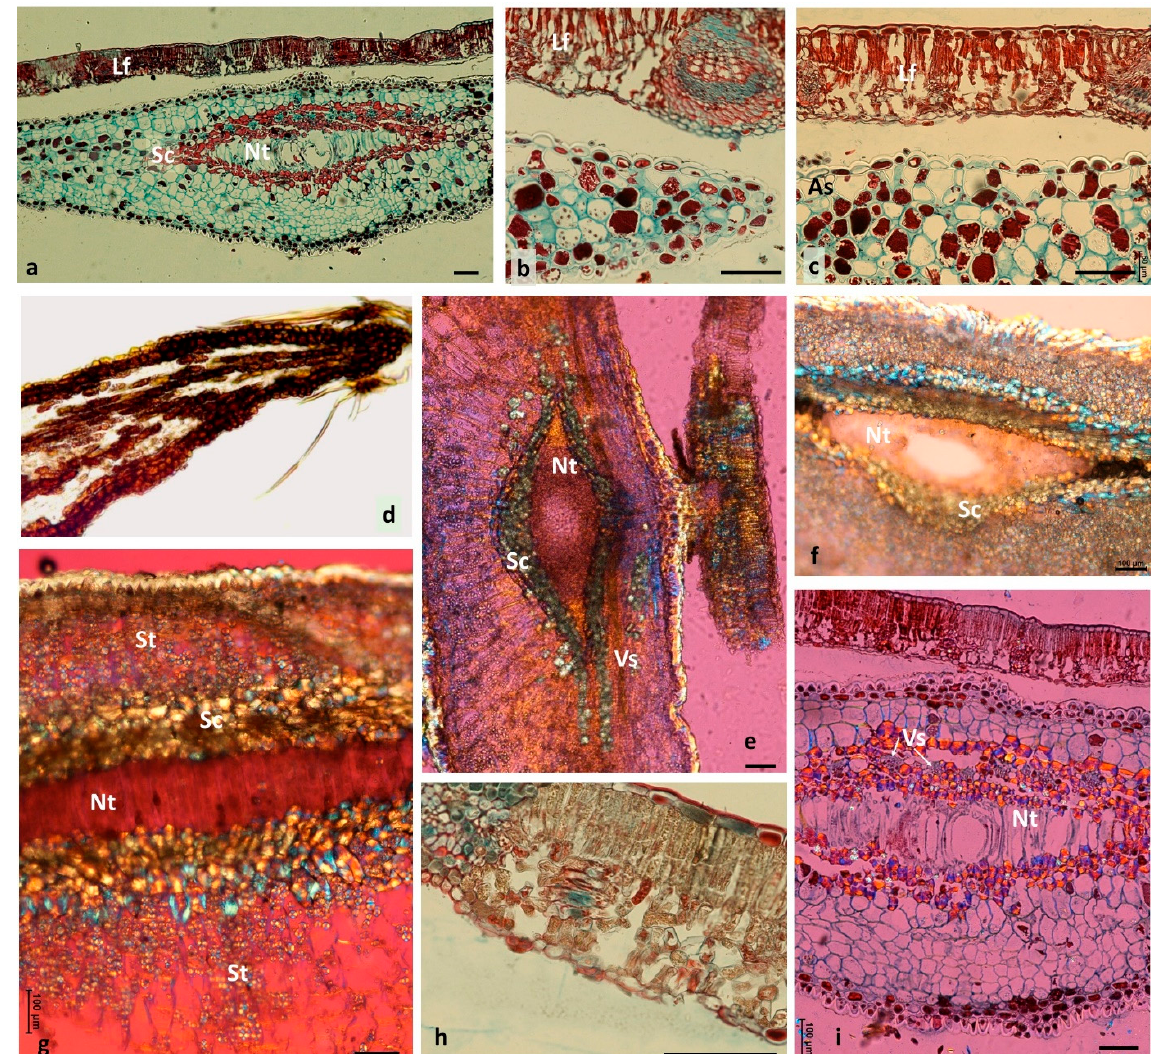
Figure 4. Spangle gall and its subtending leaf at different stages of development (LM, fast green and safranine, polarized light). ( a ) Cross-section near the middle of a gall. In the centre, the sclerenchymatous capsule (Sc) protecting the larval chamber, Nt, nutritive tissue; Lf, subtending leaf. Many cells show tannin deposits in the vacuole (brown). ( b ) Marginal part of a gall. ( c ) Cross-section through the inner part of a gall. As, large intercellular spaces looking as “breaks” in the subepidermal layer. Structure of the subtending leaf (Lf) markedly changed and heavily lignified. ( d ) Section of the gall taken in late July (not stained), irregular distribution of tannins. ( e ) Free-hand section taken in late July, not stained. Nutritive tissue shows granular structure. Cell walls not visible. ( f ) Another example of nutritive tissue without visible cell walls. Thick layer of CaOx idioblasts and sclereids above and below the larval chamber. ( g ) Cellular structure in the nutritive tissue already well-visible (mid-August). ( h ) Leaf blade beyond the influence of the gall; compare with degenerated leaf structure in Figure 4c. ( i ) Central part of a gall when nutritive tissue is already fully formed (late August). Bars represent 100 μ m.